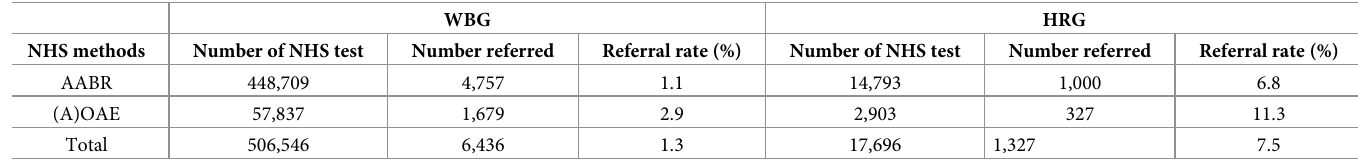
Number of missing infants was approximately 129 when we analyzed by NHS